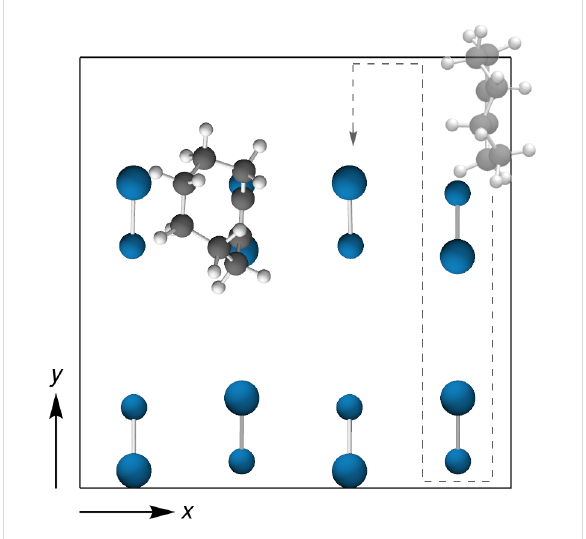
Figure 4: Si(001) Surface precovered with one adsorbate 1 and unit cell used in the PES scans (orientation of second adsorbate and scan path indicated) shown in Figure